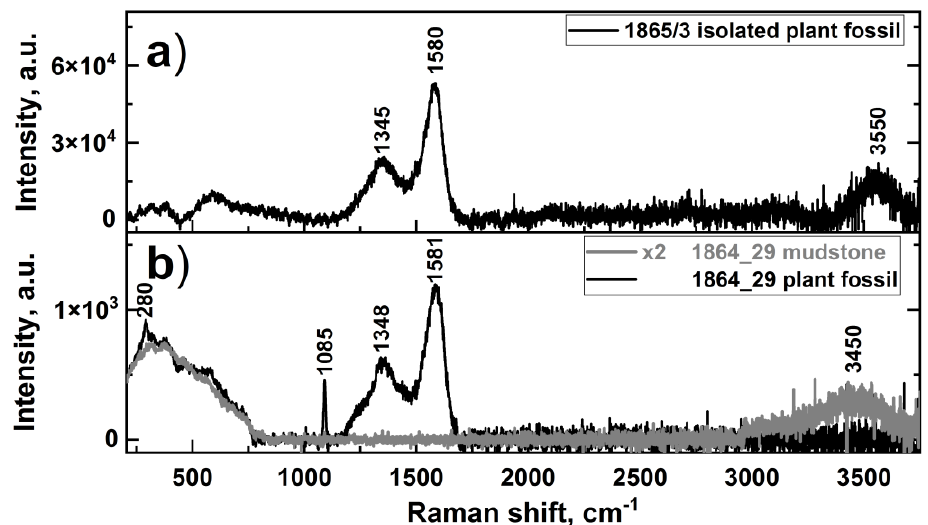
Figure 7. Continuous wave Raman spectra of isolated fossilized material 4734/67 ( a ) and 1864_29 samples at the mudstone ( b ) measured by Enspectra R532 with 532 nm. (The mudstone rock Ra- man spectrum was multiplied 2-fold for better view). Spectra were acquired with the 180 s gate and were corrected on background emission.